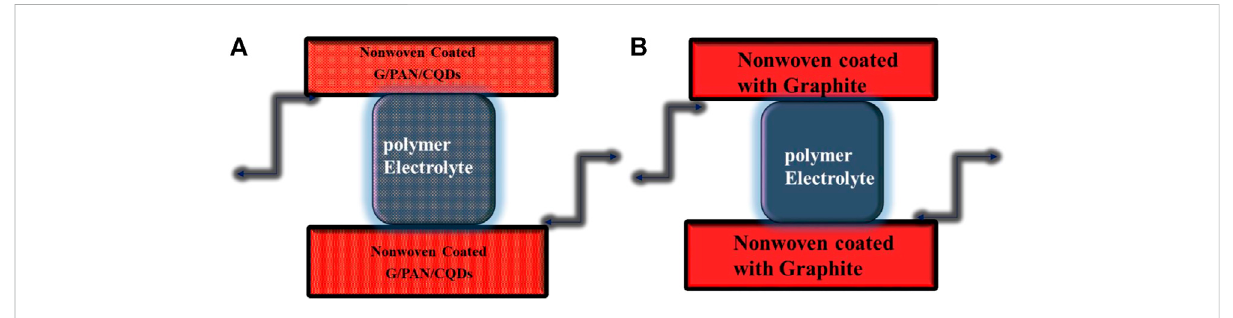
FIGURE 9 Schematic Symmetrical cell comparison (A) with CQDs and (B) without